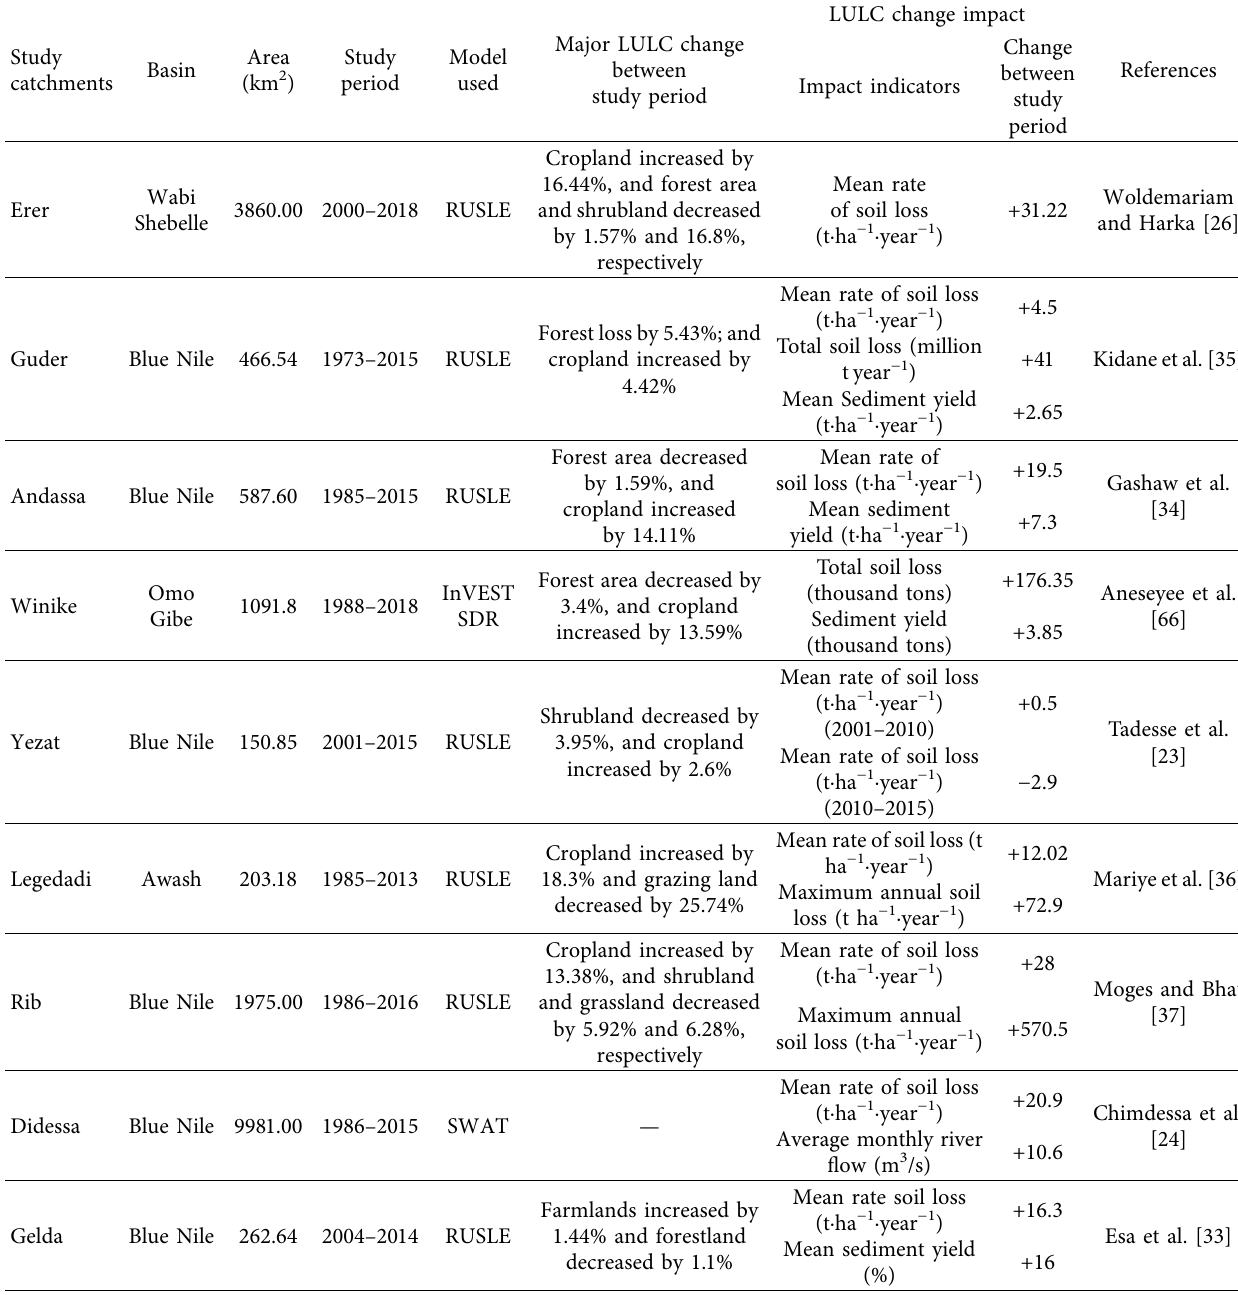
Table 1: Previous studies on LULC change impact on soil erosion in